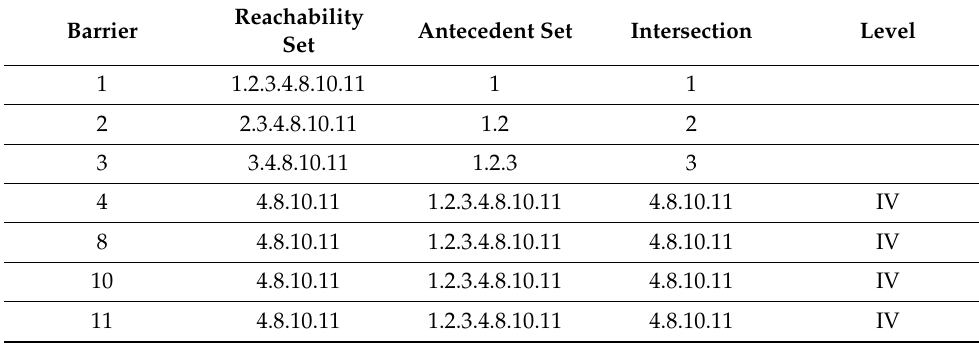
Table A7. Level Partitioning (Conventional Method)—4th Iteration.